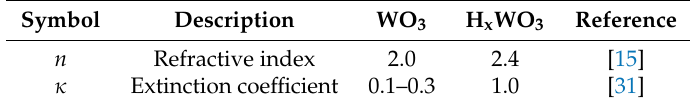
Table 2. Refractive indices and extinction coe ffi cients of tungsten oxide (WO 3 ) and tungsten bronze (H x WO 3